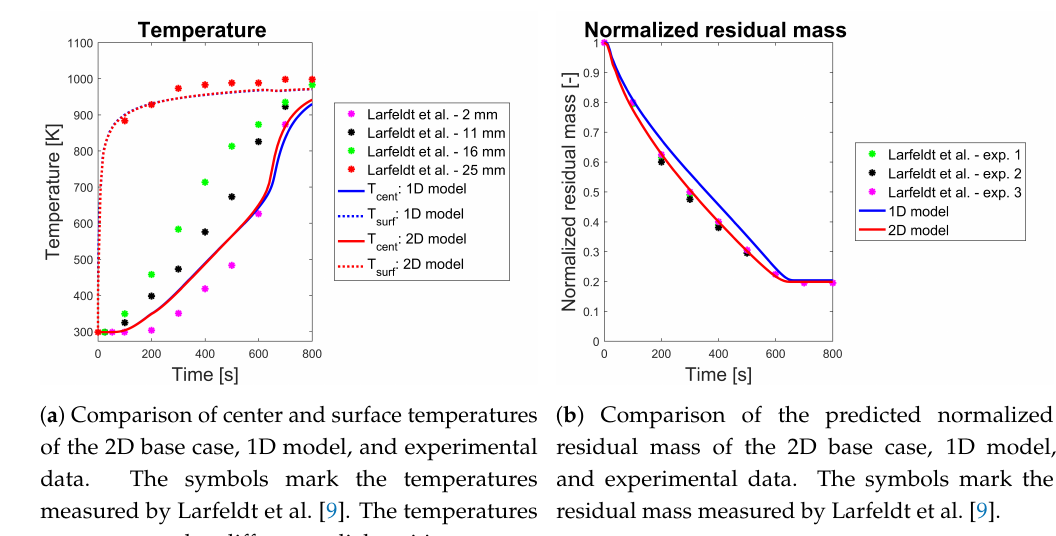
Figure 11. Comparison of degradation dynamics predicted by the 1D model and the detailed 2D model—base case. The experimental data was read out of figures as shown in Larfeldt et al. [9]. However, to clearly distinguish between simulation results and experimental data, the experimental data are not shown as continuous lines but instead as selected values (marked by